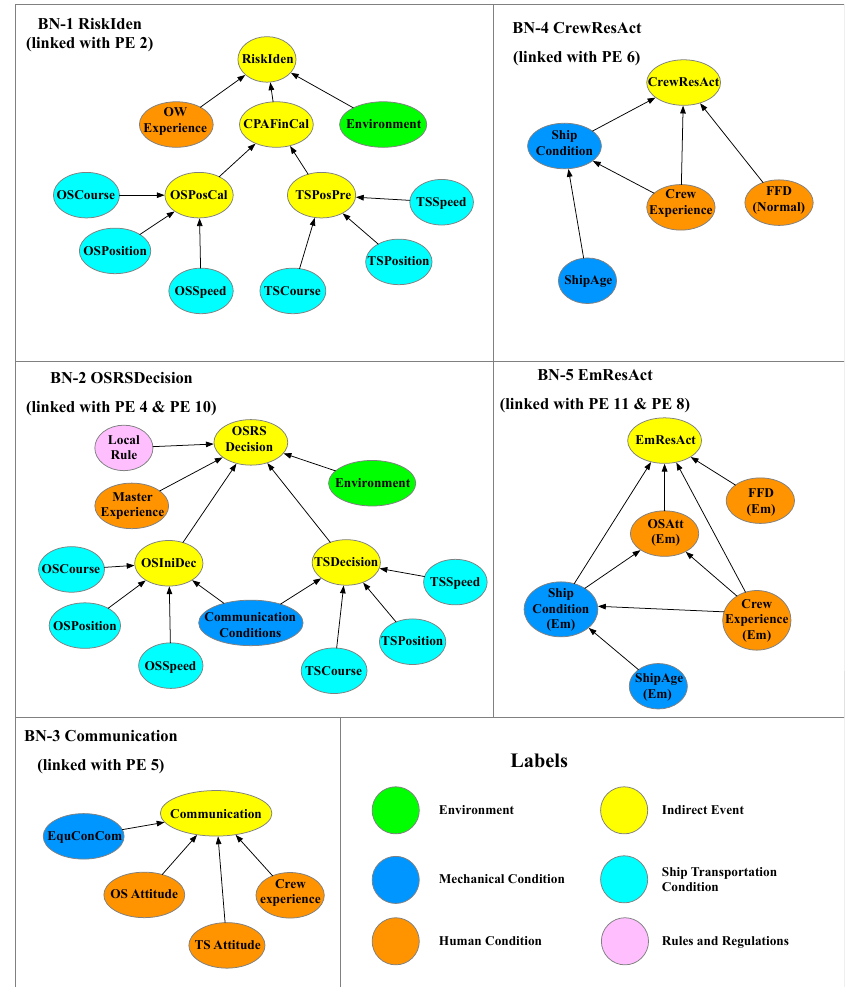
Figure 9. The BN models of the proposed HCL model